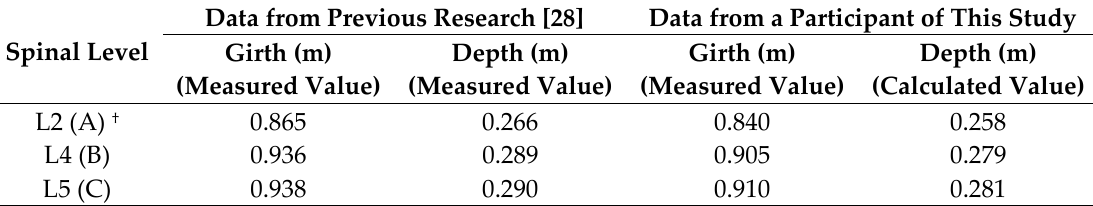
Figure 4. Musculoskeletal model of an average woman ( a ) and a pregnant woman ( b ). ( A )–( C ) express the points that were used to decide the wrapping points of the rectus abdominis and are correspondence to the ( A )–( C ) in Table 2 Table 2. Values used to determine enlarged rectus